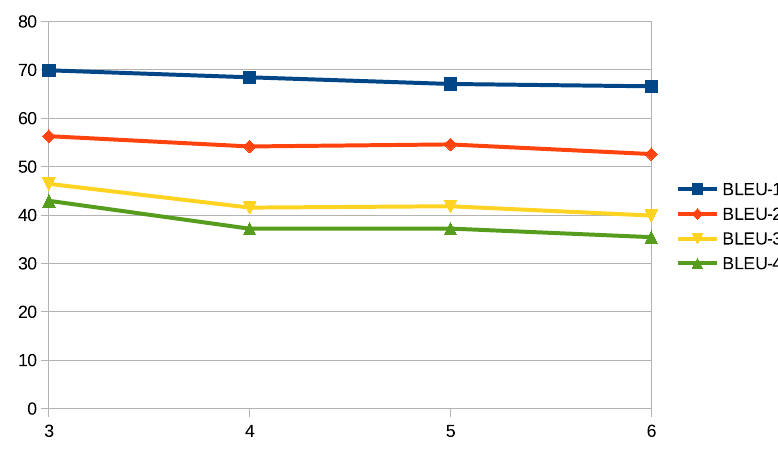
Figure 7. Comparison of the BLEU scores under different beam